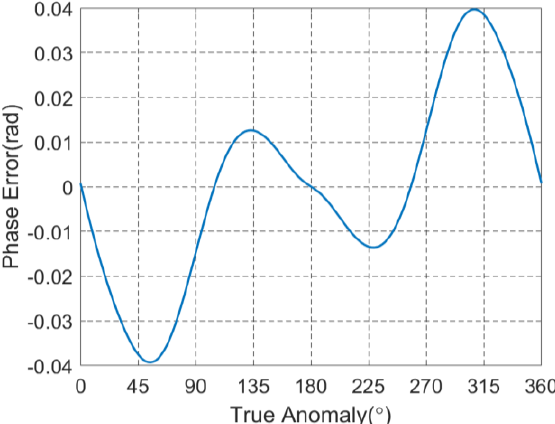
( c ) Figure 17. The fitting error and focusing result of sixth-order expansion at 45° of true anomaly. ( a ) Fitting error; ( b ) 2-D contour; and ( c ) azimuth profile. Through the above simulation results, it could be seen that since the motion state of satellite changes all the time, the range model of a certain expansion order in different orbit positions would have different fitting effects. The perigee and apogee are always positions with the minimum fitting error, so it is insufficient to verify models or algo- rithms at only those positions. In conclusion, the expansion order should be determined by the maximum fitting error of the whole orbit, or using different expansion order at different orbit positions for the purpose of reducing the computational burden. 4.4. Focusing Results with Ultralong Integration Time In order to verify the effectiveness of the m th-order Taylor expansion for target fo- cusing with ultralong integration time, a series of simulation experiments for point targets imaging were conducted. The simulation parameters are shown in Table 1, and the orbit was chosen as the “8” shaped orbit. The integration time was 2000 s in these experiments, and the expansion order of pulse transmitting distance was sixth. Figure 18 shows the relationship between the fitting error of the sixth-order Taylor expansion and orbit posi-